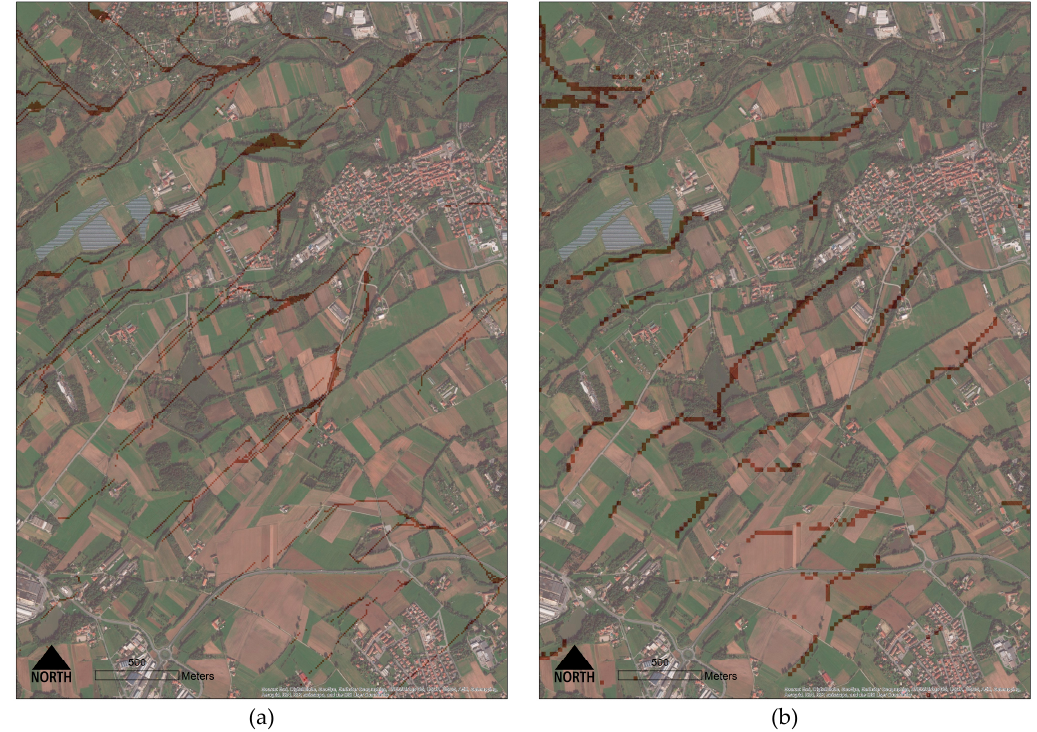
Figure 3. Correspondence between model streams and the real water bodies. In the left image ( a ), the runoff model generates streams that are poorly correspondent to the existing watershed (DEM 10 m) while, on the right ( b ), the model generates streams fairly correspondent to the existing watershed (DEM 25 m). Land 2017 , 6 , 48